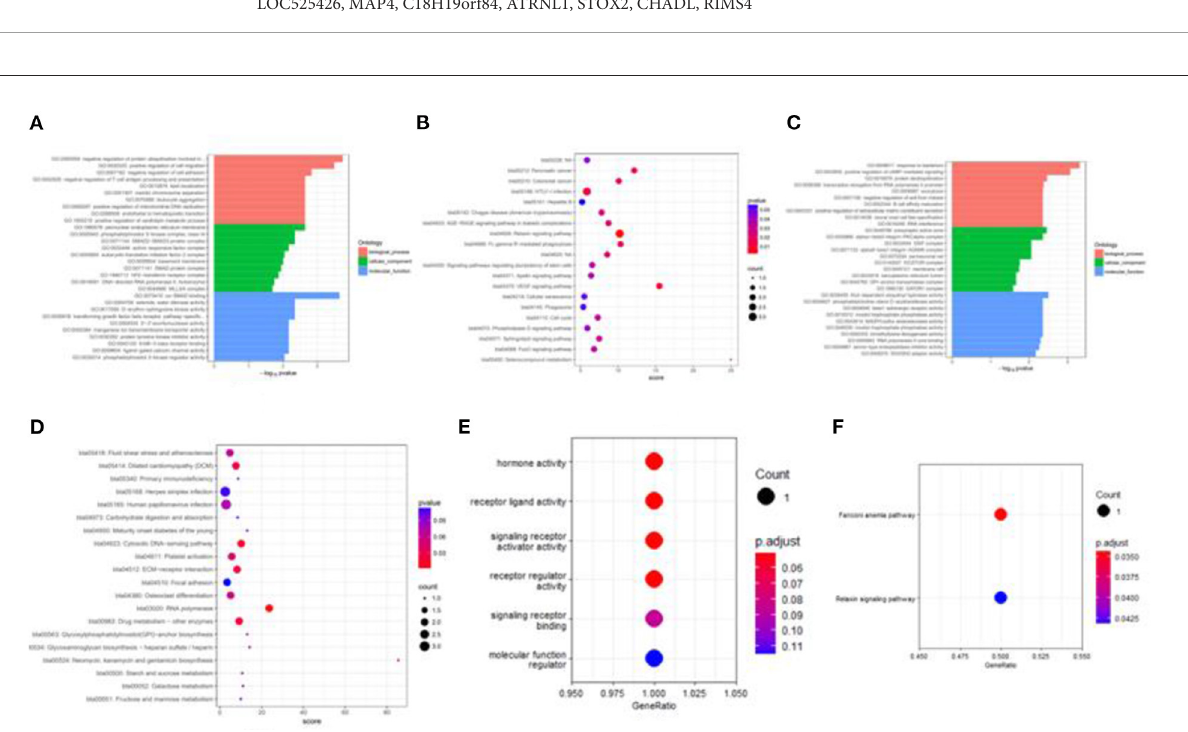
FIGURE8 Target genes GO and KEGG enrichment top bar plot and point plot of different groups. (A) Top 30 bar plot of enriched GO terms of DE miRNAs target genes in the H vs. P group. (B) Top 20 points plot of KEGG pathway of DE miRNAs target genes in the H vs. P group. (C) Top 30 bar plot of enriched GO terms of DE miRNAs target genes in the M vs. P group. (D) Top 20 points plot of KEGG pathway of DE miRNAs target genes in the M vs. P group. (E) Point plot of miR-7 target genes enriched GO terms. (F) Point plot of miR-7 target genes enriched